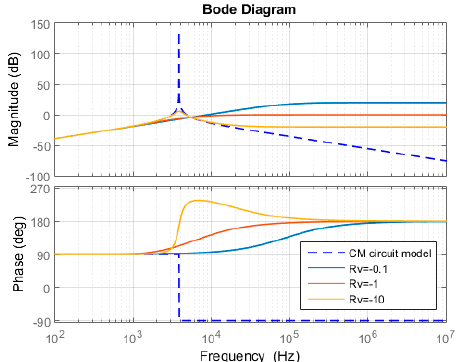
Figure 8. Bode diagram CM power stage: without R v and with R v connected in parallel with L f.